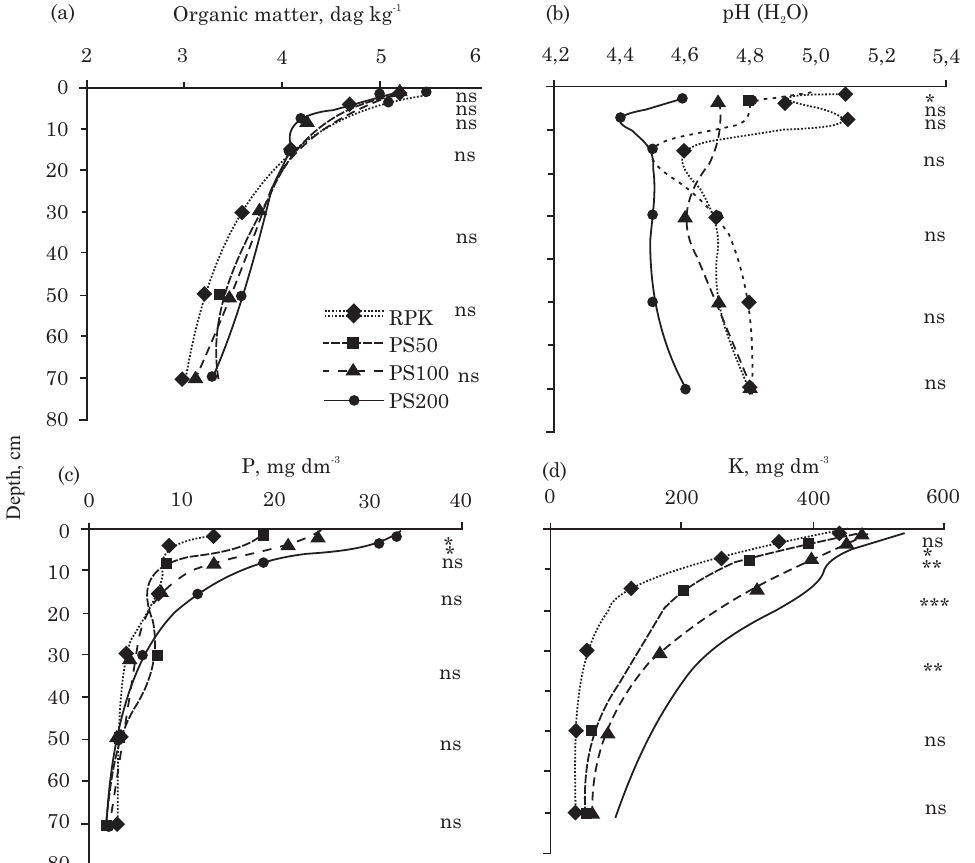
Figure 2. Soil chemical properties throughout the profile of an Hapludox soil in the 12 th year of replacement of P + K exported in harvested grain (RPK) and pig slurry applications (PS50, PS100, and PS200); PS50, PS100, and PS200 represent application rates of 50, 100, and 200 m 3 ha -1 yr -1 of pig slurry, respectively; ns, *, **, and *** denote non-significant differences and differences at significance at 5, 1 and 0.1 %, respectively.